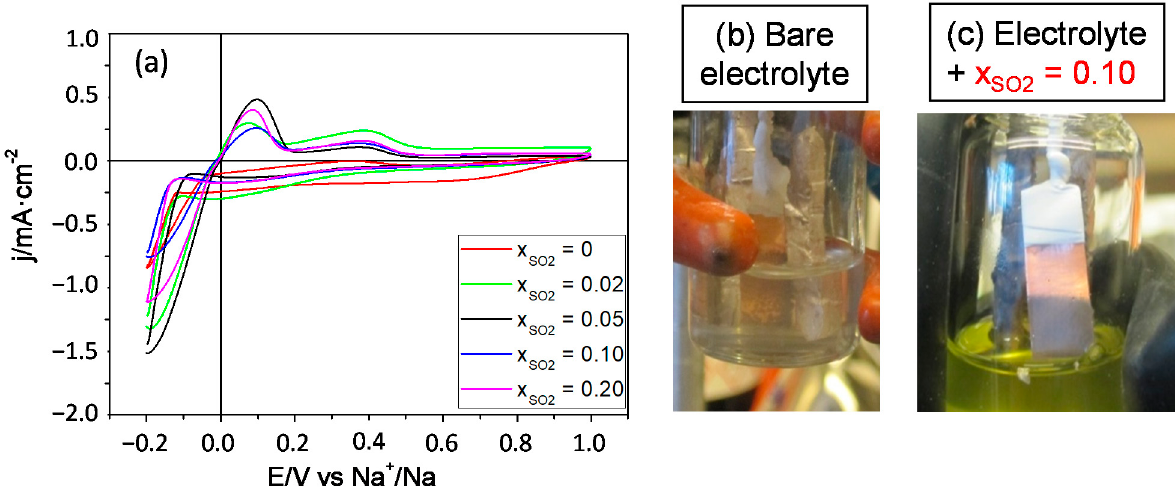
Figure 3. ( a ) CVs for the deposition of Na on Cu in 2 M NaSCN/DOL:DME at 20 mV s − 1 for different mole fractions of SO 2 . Pictures ( b , c ) show the sodium deposit morphology on Cu before ( b ) and after ( c ) adding an SO 2 mole fraction of 0.10. They were taken after applying a potential of − 0.2 V vs. Na + /Na for 500 s.